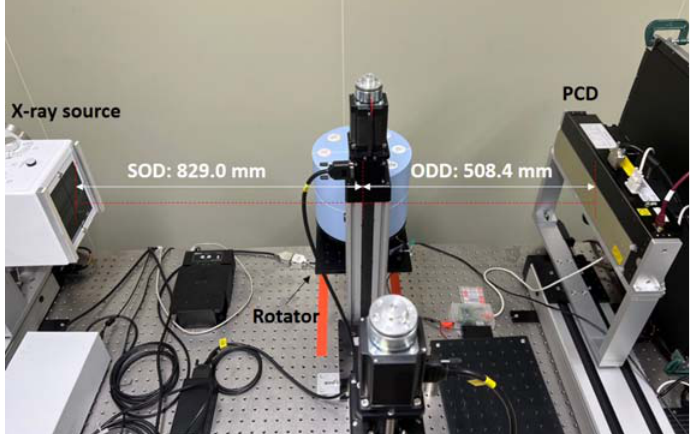
Figure 2. A photon counting detector (PCD) computed tomography (CT) system used in this study. There is a rotating platform between the X-ray source and the line type detector. Abbreviations: source to object distance (SOD); object to detector distance (ODD).